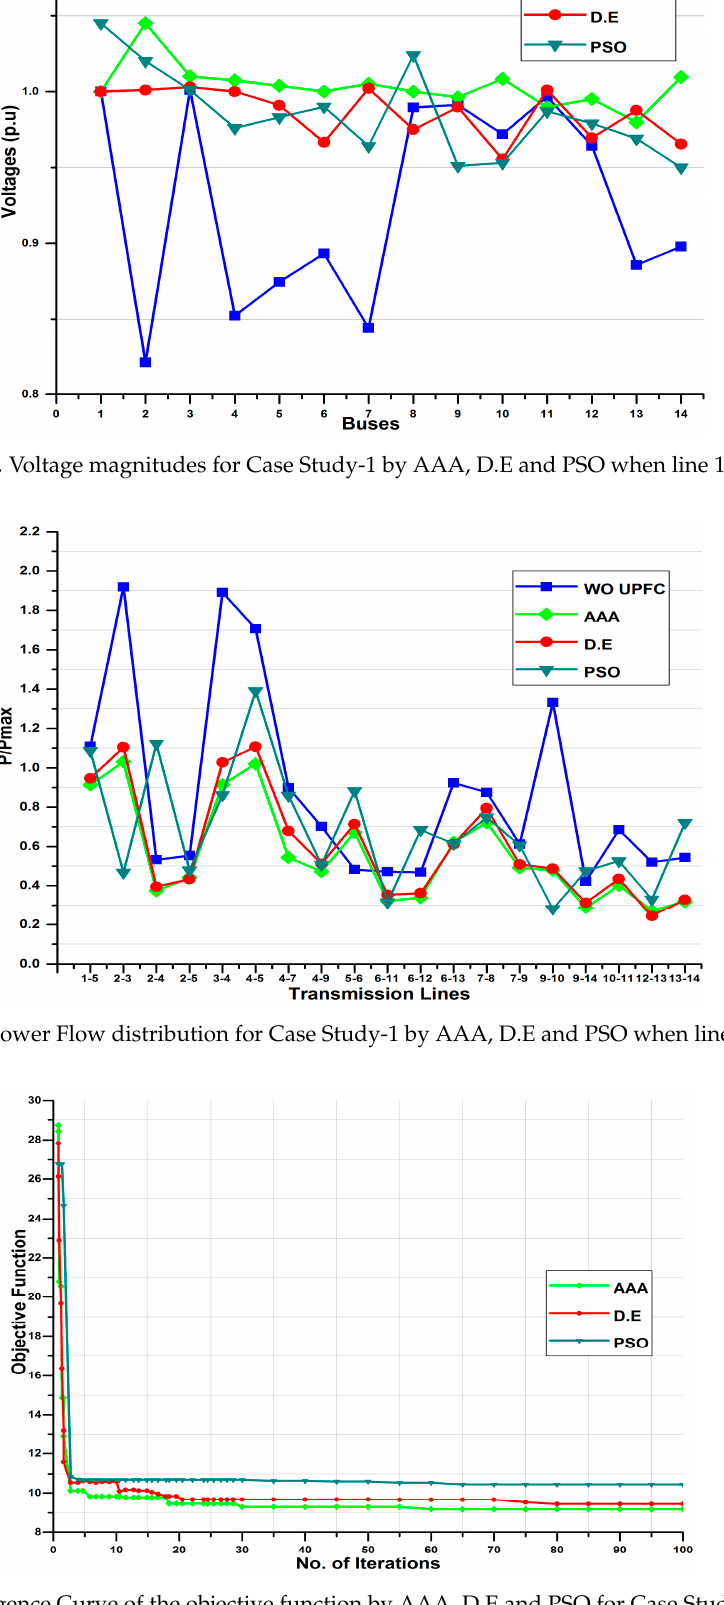
Figure 6. Convergence Curve of the objective function by AAA, D.E and PSO for Case Study-1 (line 1 trip).